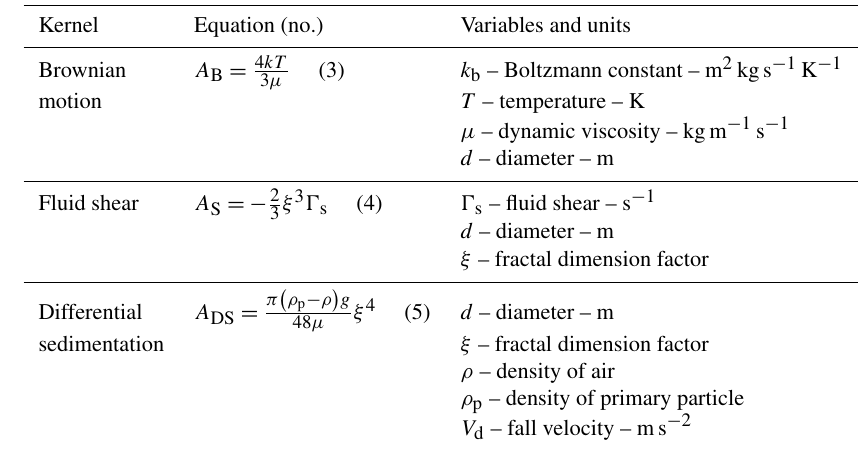
Table 1. Derived coagulation kernel equations used in the calculation of (cid:49)N